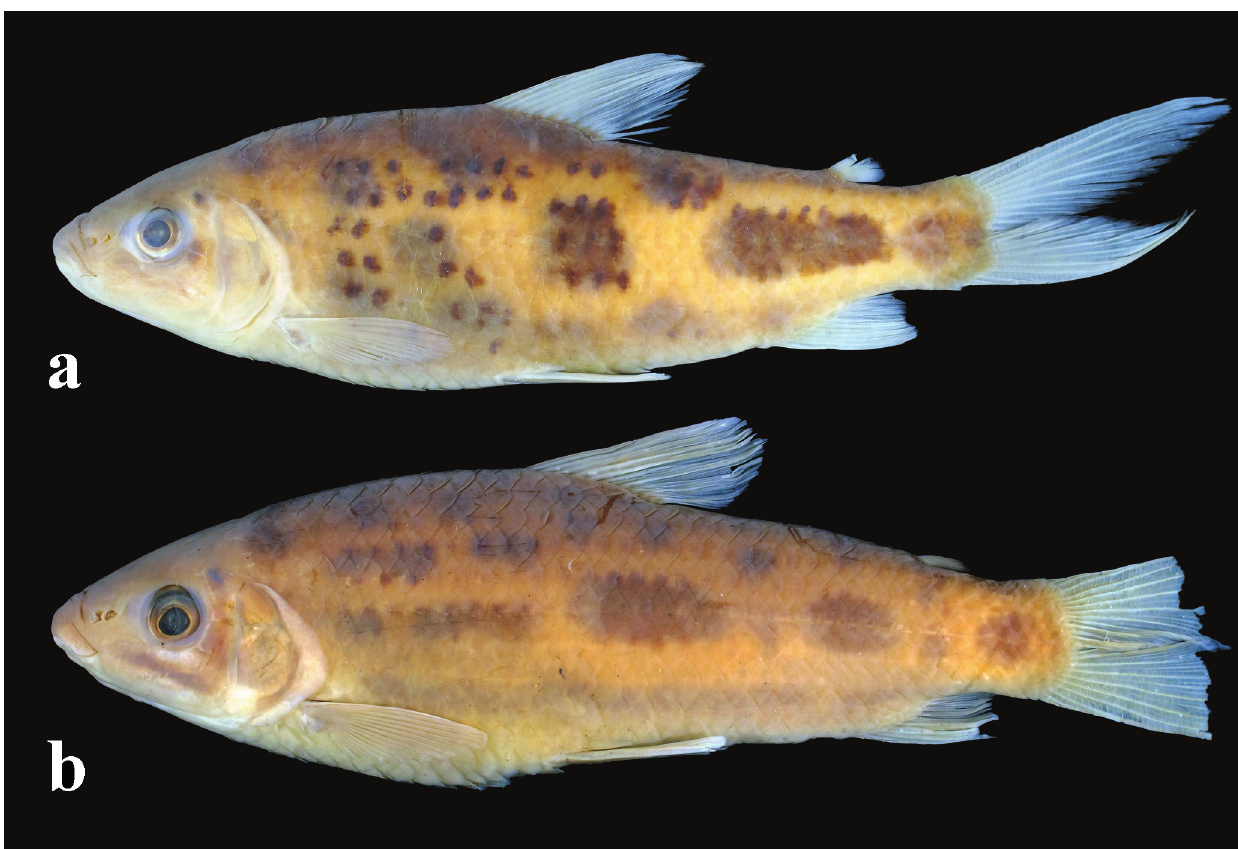
Fig. 5. Leporinus gomesi ( a ), MZUSP 14441, paratype, 104.3 mm SL, igarapé da Chapada, tributary of igarapé do Aeroporto, rio Aripuanã drainage, Aripuanã, Mato Grosso, Brazil; Leporinus nijsseni ( b ), MZUSP 48506, 138.5 mm SL, Sara creek, Brokopodo,